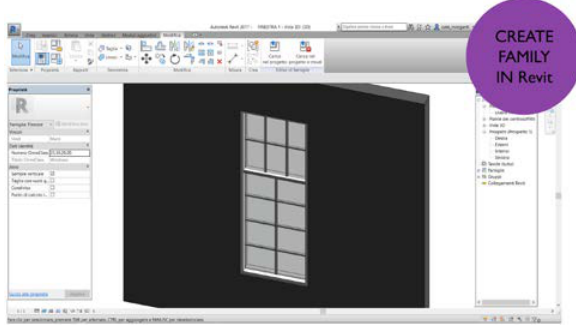
Figure19: Creation Family in Revit.